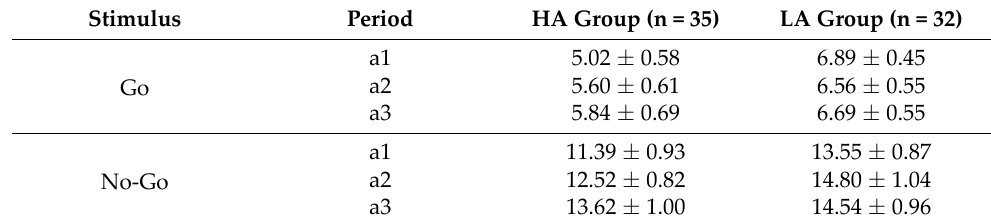
Table 4. Mean latencies of the SP (ms) (M ± SEM).